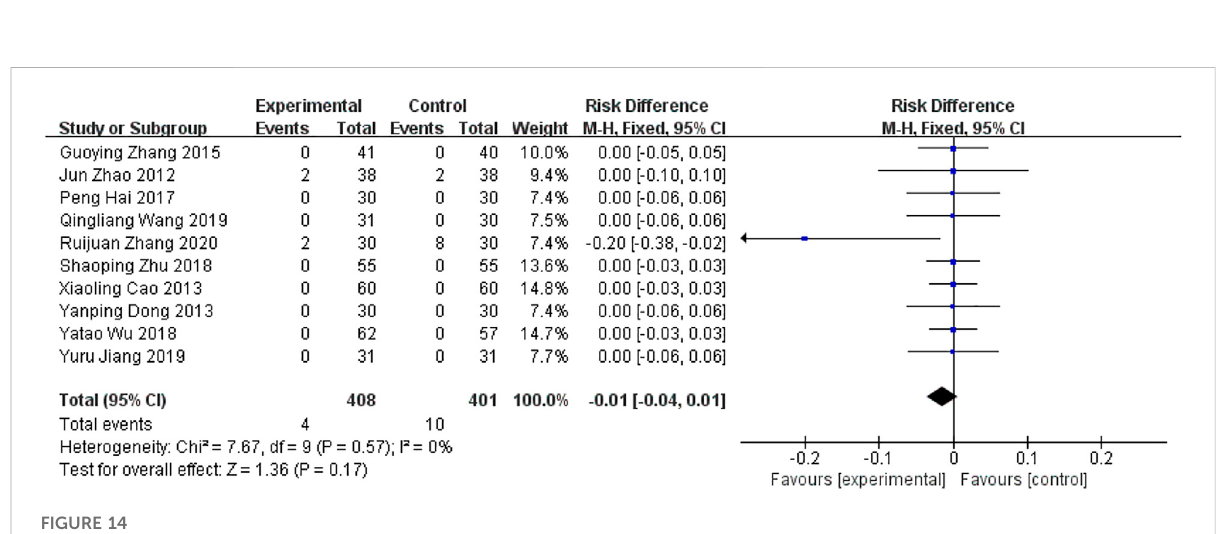
FIGURE 14 Forest plot of incidence for adverse